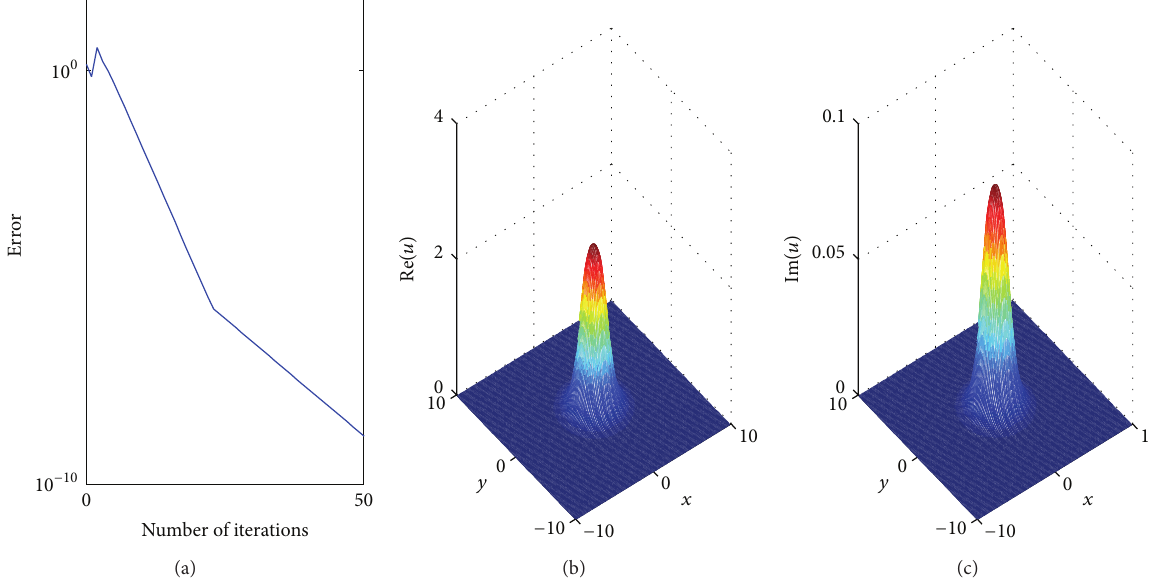
Figure 5: Convergence analysis for lattice soliton corresponding to the second renormalization factor with 𝜇 = 1.71 .